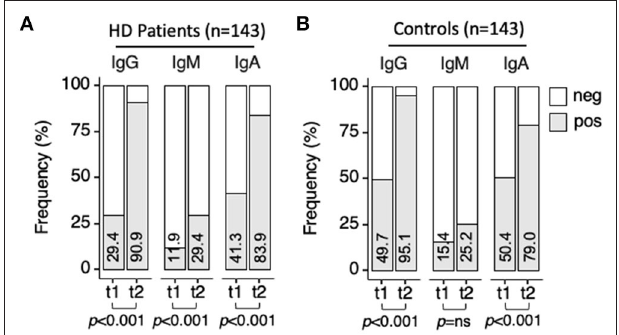
FIGURE 2 | Anti-SARS-CoV-2-spike seroconversion upon vaccination. Sera collected at t1 and t2 were analyzed for anti-spike IgG, IgM, and IgA antibodies by ELISA. ODnorm ≥ 1 was used as cut-off for positivity. Frequency of samples testing positive (gray bar) at t1 or t2 for each antibody class. (A) HD patients ( n = 143). (B) controls ( n = 143). Percentage of seroconversion indicated inside each bar. Pearson’s Chi-squared test (with Yates’ continuity correction) was used to determine differences over time in patients and controls ( p- values indicated in the figure) and between patients and controls at t1, and t2 ( p- values indicated in Supplementary Tables 1, 2 ). neg, negative; pos, positive; t1, sera collected 21 days post-first vaccine dose; t2, sera collected 42 days post-first vaccine